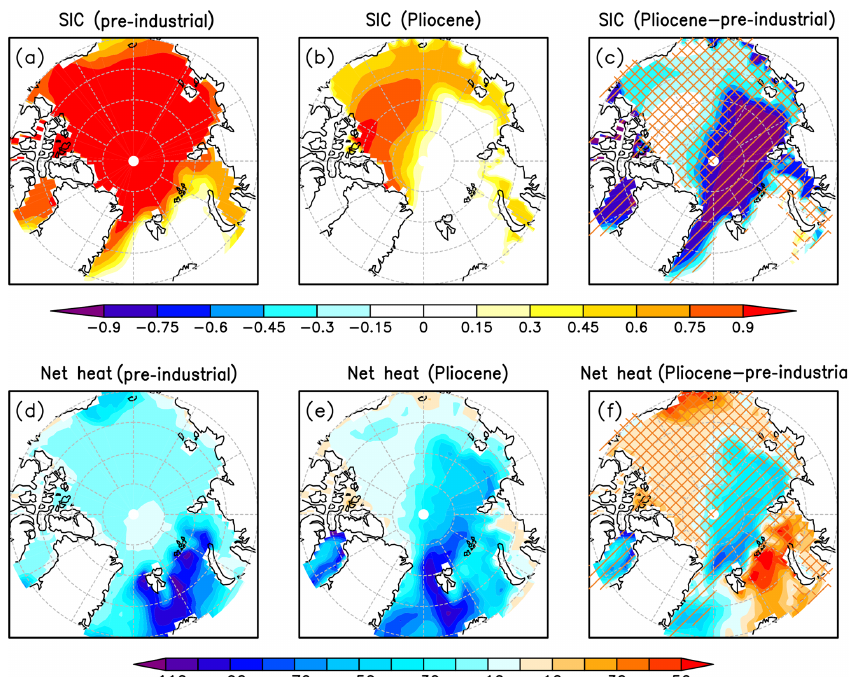
Figure 2. Spatial distributions of the annual mean sea ice concentration (SIC) and net heat flux at the surface of ice and ocean (Wm − 2 , positive downward) over the Arctic Ocean. (a) SIC in the pre-industrial period, (b) SIC in the Pliocene, (c) the Pliocene SIC change with respect to the pre-industrial period, (d) net heat flux in the pre-industrial period, (e) net heat flux in the Pliocene and (f) the Pliocene net heat flux change with respect to the pre-industrial period. The diagonal stripe in (c) and (f) represents the regions from ice-covered to ice-free, and the diagonal crosshatch represents the regions from ice-covered to